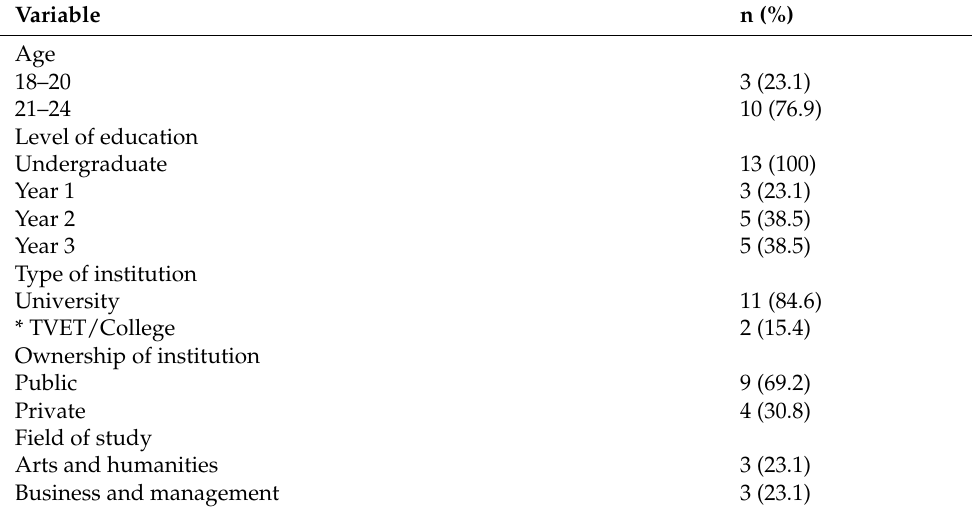
Table 1. Demographic characteristics of TSMSM participants (n =